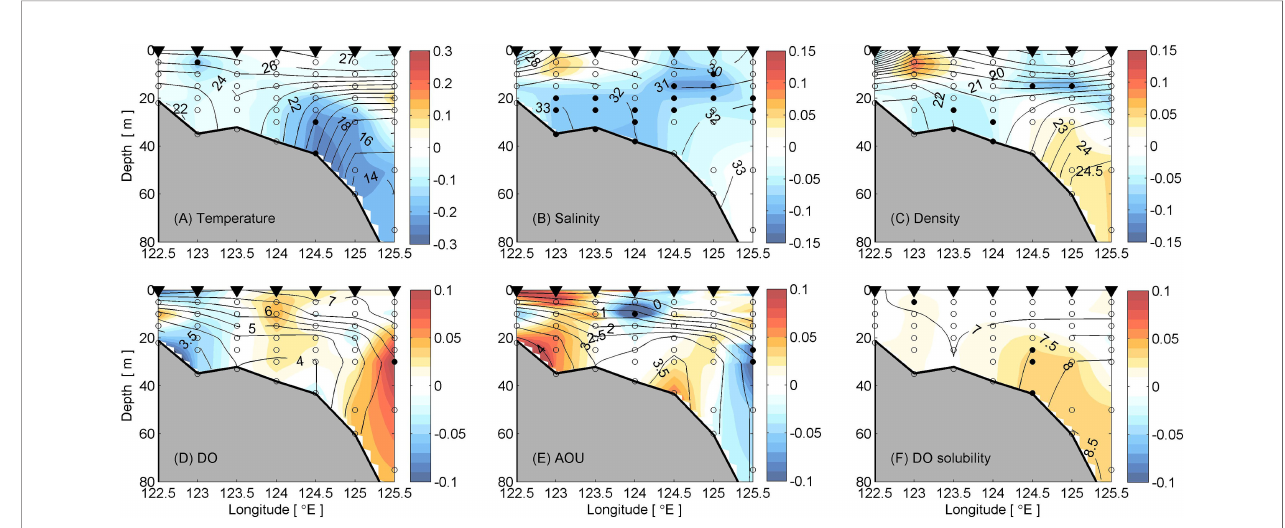
FIGURE 2 | Climatology mean and linear trend of hydrological parameters along Section C-C in summer. The dots indicate signi fi cant trend at 95% level, triangles mark the sampling stations, and open circles indicate insigni fi cant trend. (A) Temperature with units °C and °C/year. (B) Salinity. (C) Density with units kg/m 3 and kg/ m 3 /year. (D) DO with units mg/L and mg/L/year. (E) AOU with units mg/L and mg/L/year. (F) DO solubility with units mg/L and